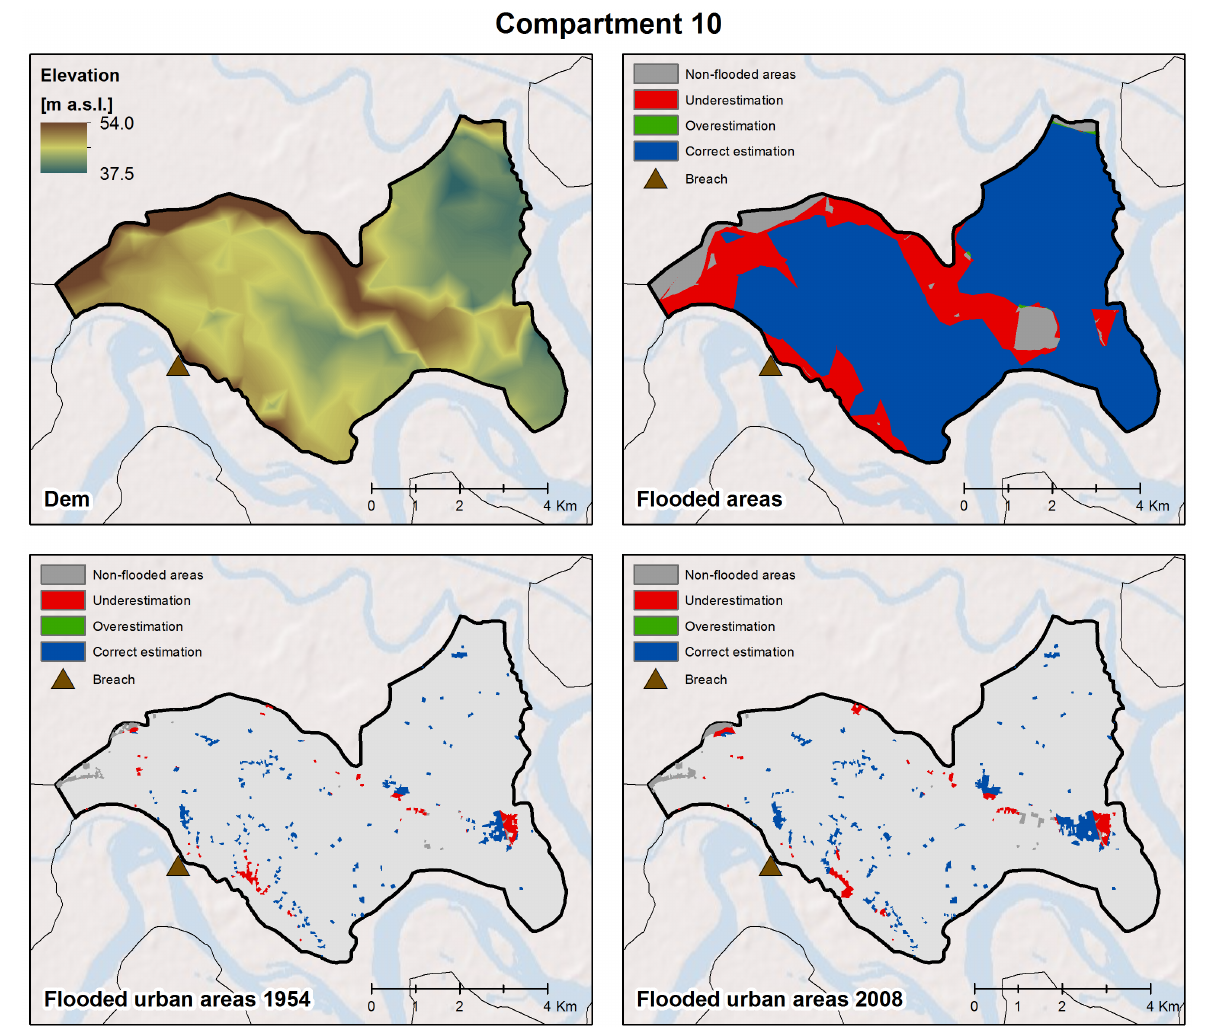
Figure 3. Compartment 10: DEM and comparison between the quasi-2-D and the fully-2-D model in terms of flooded areas (top panels) and flooded urban areas in 1954 and 2008 (bottom